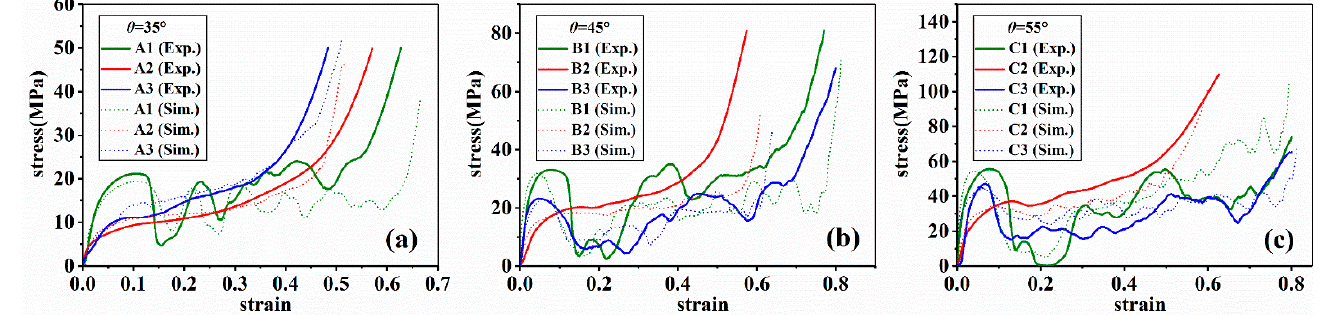
Figure 7. The stress–strain curves of samples; ( a – c ) represent Group A, B, and C respectively.